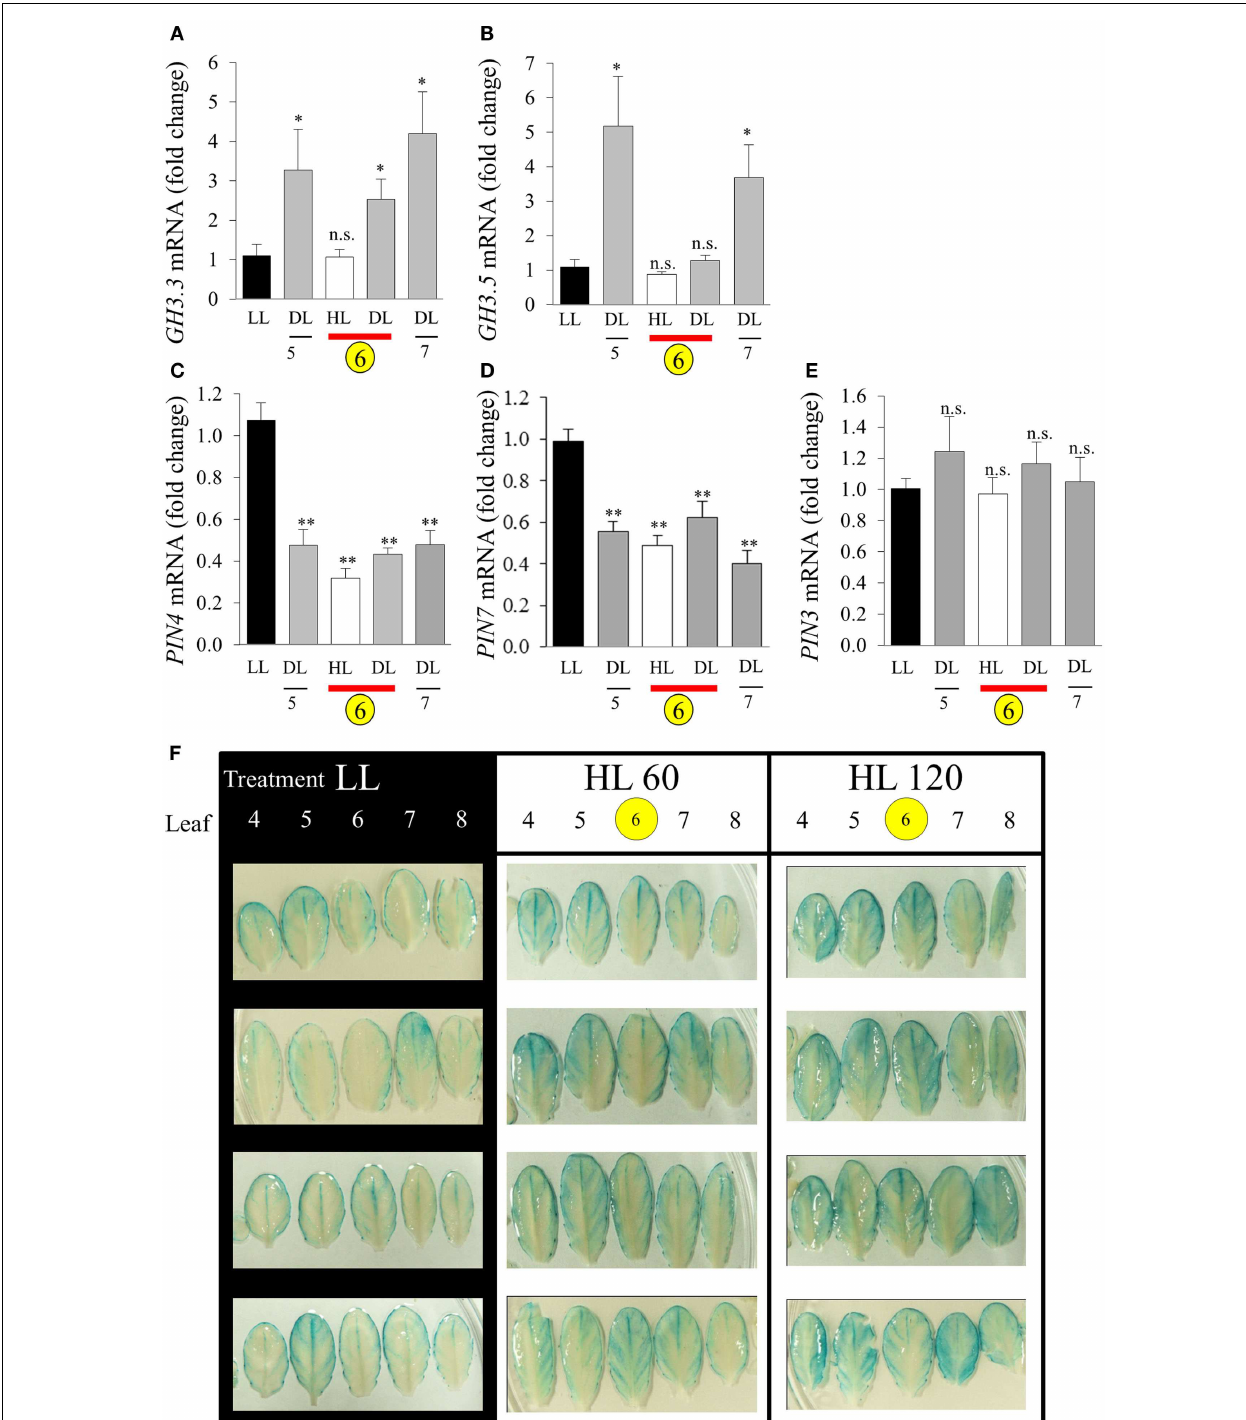
following illumination with either LL conditions (40 ± 25 µ molphotonsm − 2 s − 1 ), HL LED-array treatment of leaf 6 (1500 ± 50 µ molphotonsm − 2 s − 1 ) for either 60 (HL 60), or 120min (HL 120). Pairwise t -tests were performed comparing the transcript levels in HL and DL samples with those of LL samples yielding p -values as shown Error bars indicate standard error, for each sample type, n = 6, * p < 0.05, ** p < 0.001, n.s., not significant. n = 8 Per leaf for two independent auxin